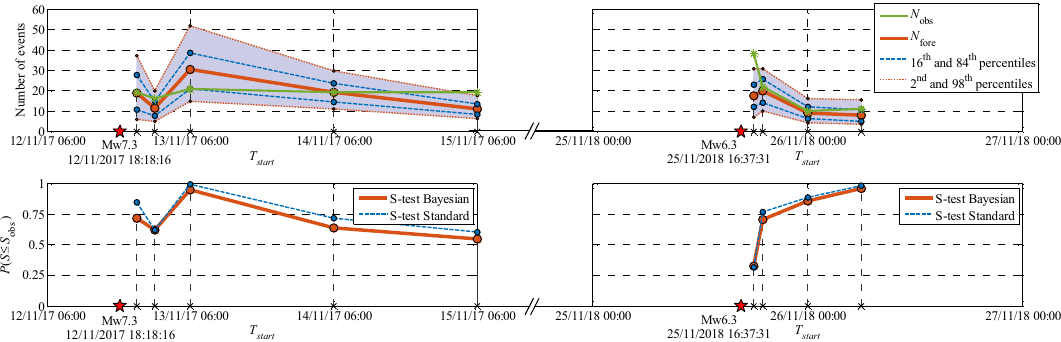
Figure 9. Summary and timeline of the evolution of N-Test and S-test results for Phase 1 (left column) and Phase 3 (right